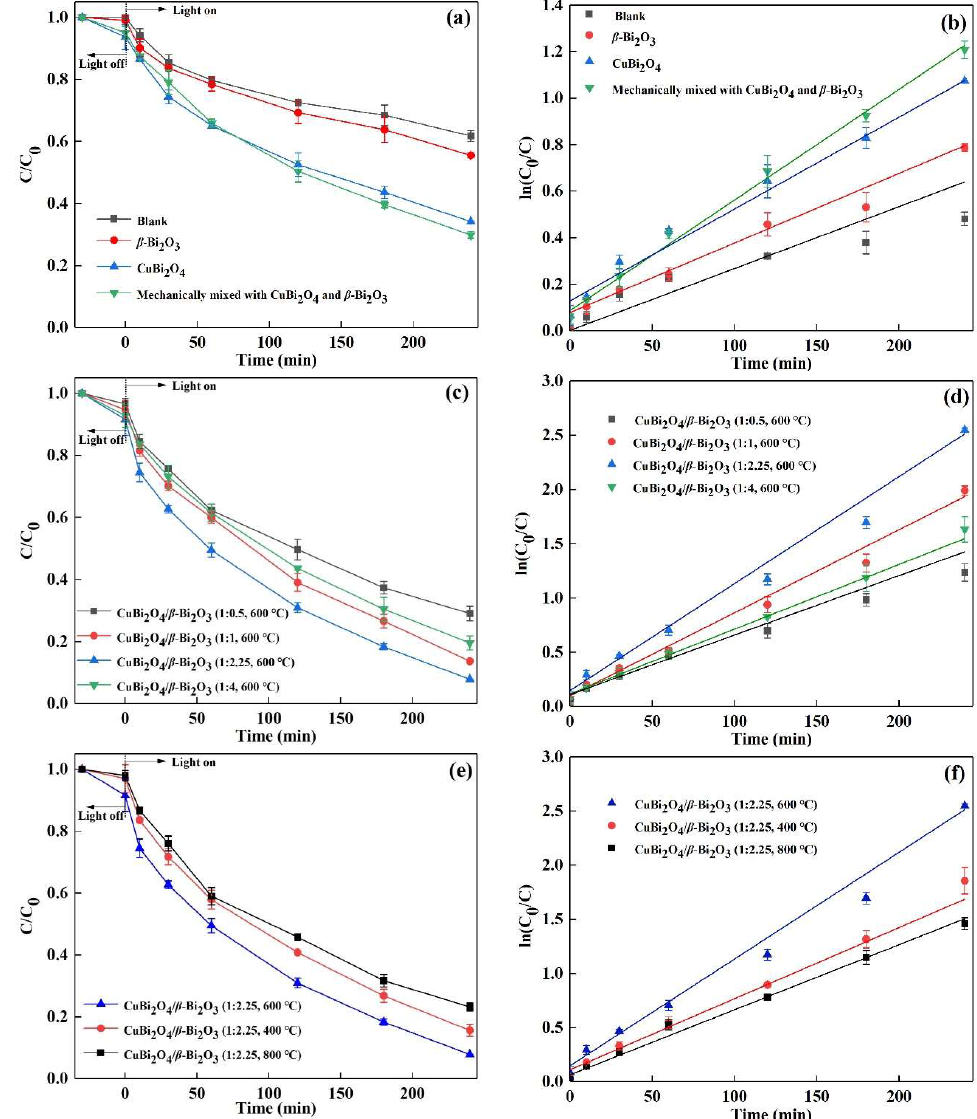
Figure 5. Diclofenac sodium (DS) degradation efficiency in the photocatalytic system of ( a ) blank irradiation, CuBi 2 O 4 , β -Bi 2 O 3 and CuBi 2 O 4 + β -Bi 2 O 3 ; ( c ) CuBi 2 O 4 / β -Bi 2 O 3 with different mass ratios; ( e ) CuBi 2 O 4 / β -Bi 2 O 3 with different calcination temperatures; ( b , d , f ) plots of ln(C 0 /C) versus irradiation time over different photocatalytic systems.